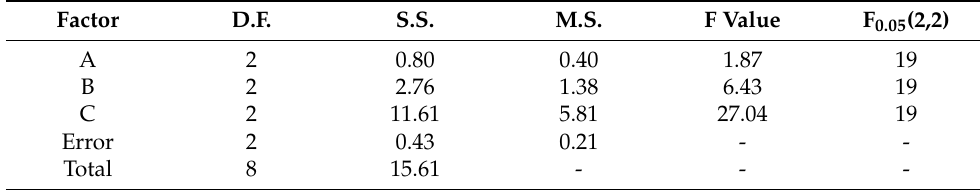
Table 4. ANOVA of the surface roughness.